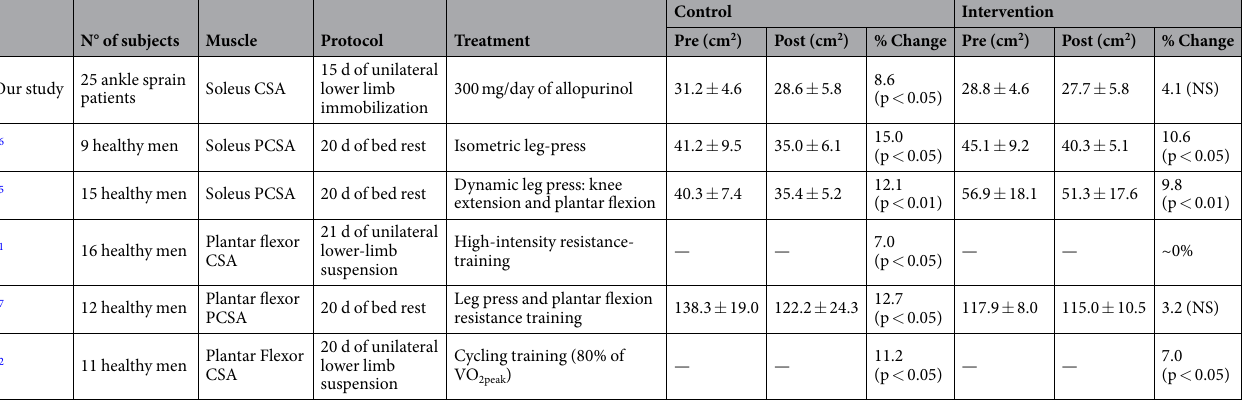
Table 1. Summary of the human studies in which the plantar flexor or the soleus muscle atrophy has been treated with exercise. Comparison with the results achieved in our study. PCSA: Physiological Cross Sectional Area. PCSA = Muscle Volume × Cosine of the muscle fiber pennation angle × (fibre length) − 1 . NS: Not